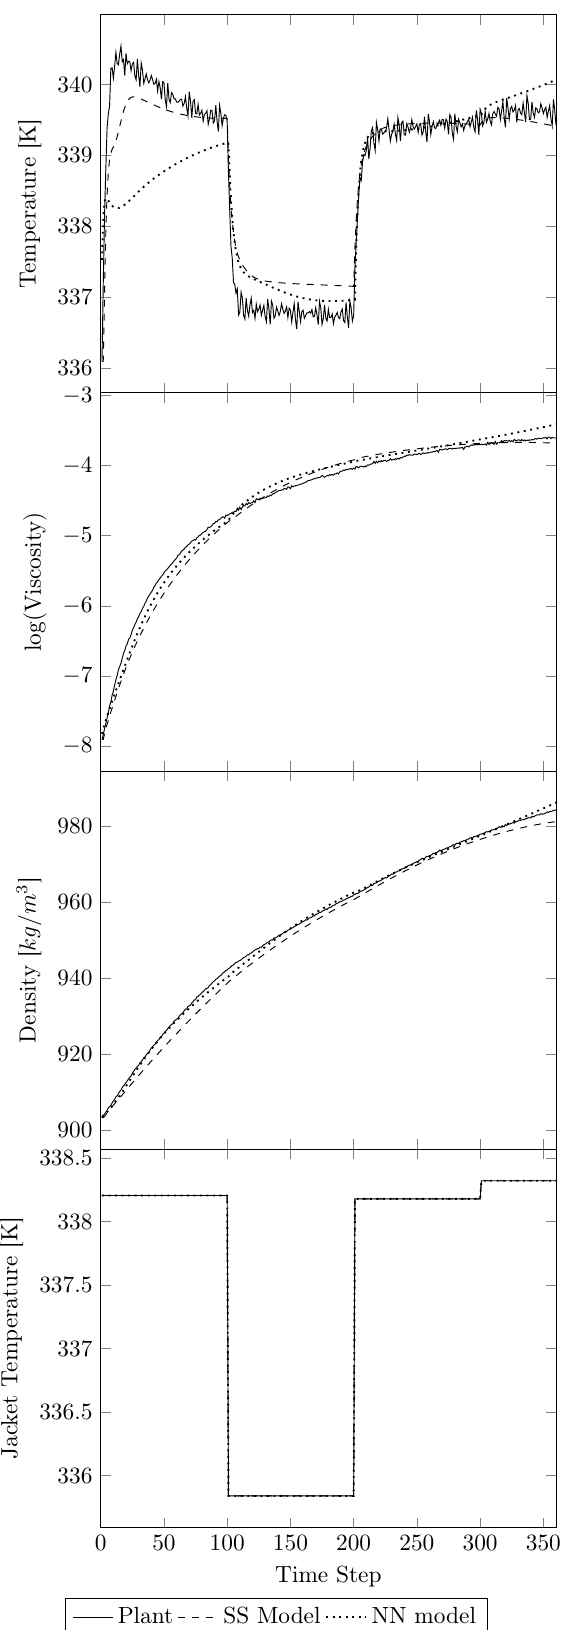
Figure 7. Validation of state-space models and NARX networks subject to measurement noise and using distinctly generated input